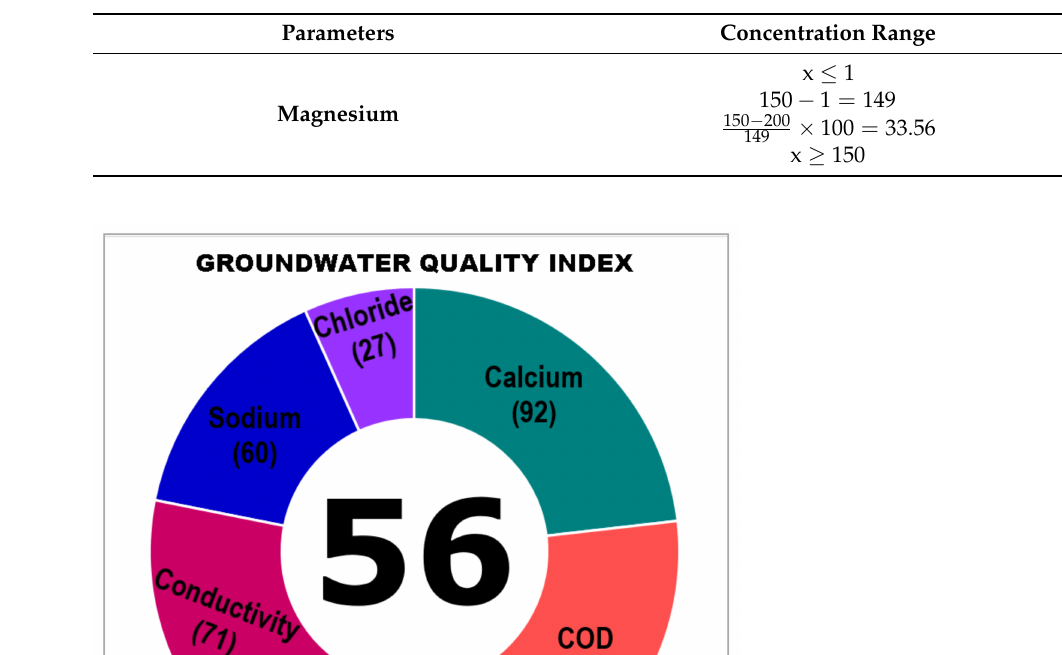
Table 15. Subindex calculation by concentration increment.